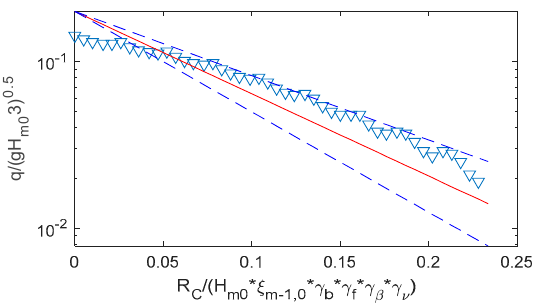
Figure 11. Comparison to Van Gent [4] (red solid line: prediction using mean value approach of Van Gent; dashed line: ± 1.64 σ ; and triangle: SWASH values).